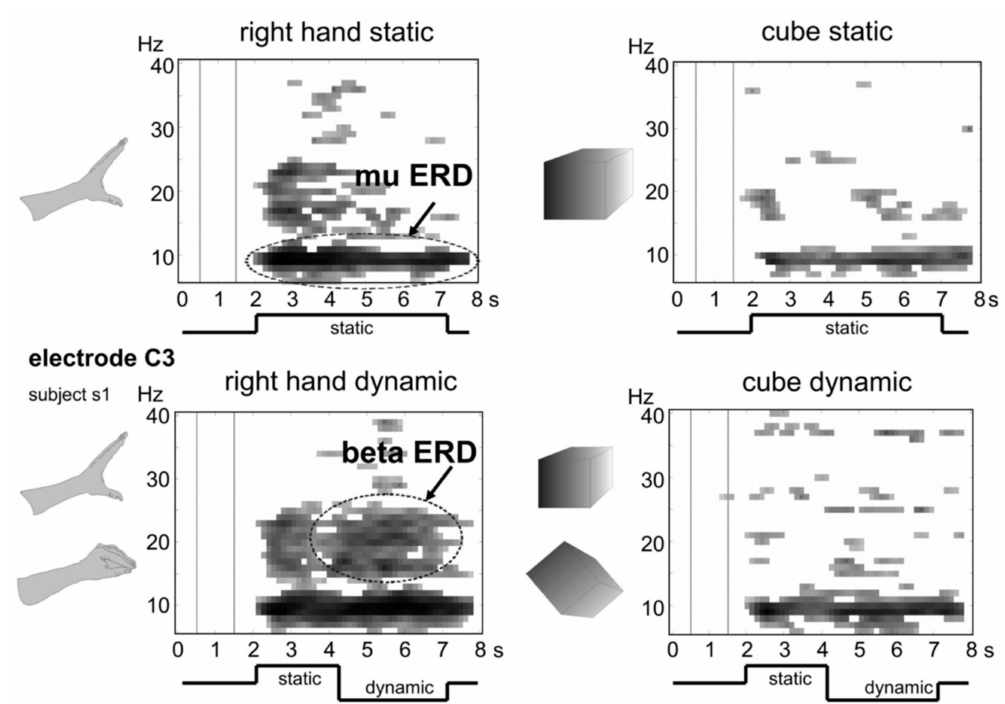
Figure 8. ERD/ERS time-frequency maps (6–40 Hz, 0–8 s) from bipolar recording over left cortical hand representation area of subject S1. A significant ERD in the alpha band in all four conditions is visible, along with an initial beta ERD during static and dynamic hand presentation and a further beta ERD only during observation of hand movement. All rights reserved, with permission from the Massachusetts Institute of Technology. Reference